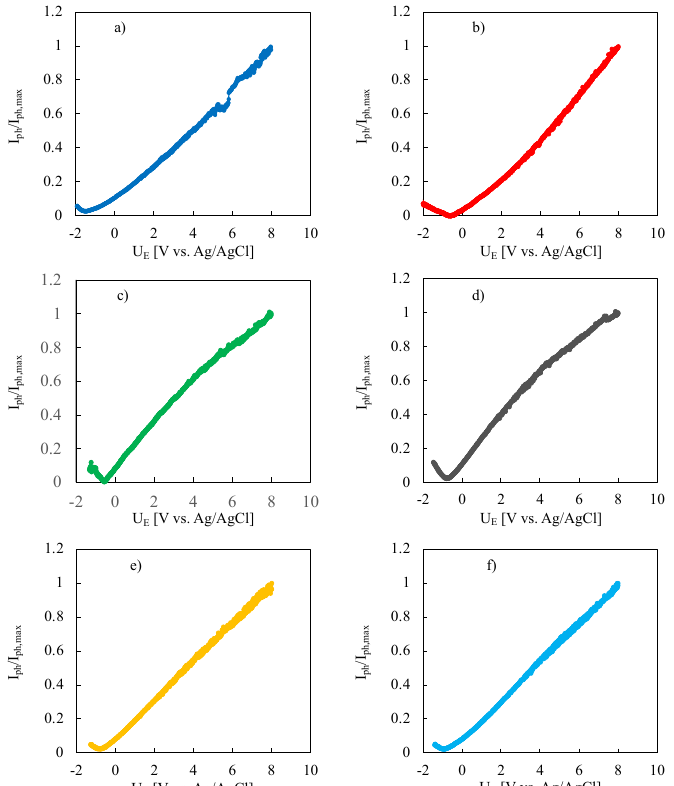
Figure 3. Normalized photocharacteristics relating to anodic films grown up to 50 V in ABS on ( a ) Ta, ( b ) Ta-19at% Nb, ( c ) Ta-39at% Nb, ( d ) Ta-66at% Nb, ( e ) Ta-85at% Nb and ( f ) Nb. Irradiating wavelength: 260 nm. Potential scan rate: 10 mV s − 1 . Solution: 0.1 M ABE.